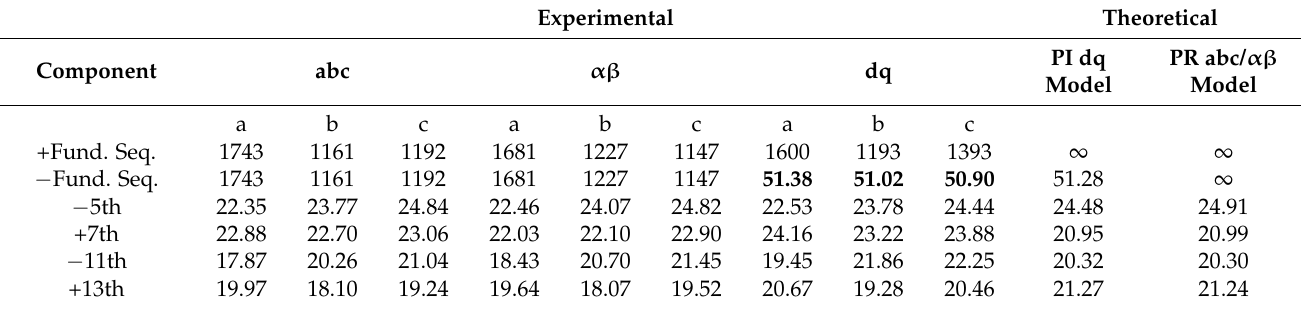
Table 3. Comparison between experimental and theoretical dynamic stiffness values ( Ω ).